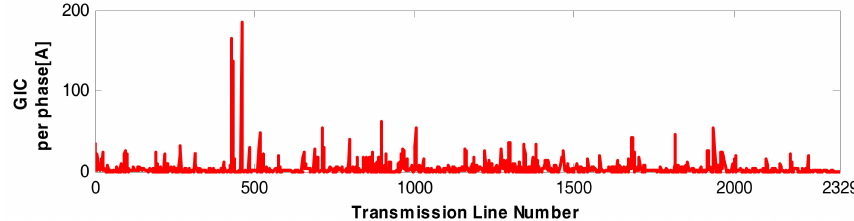
Figure 5. GIC per phase (in absolute value) on the Transmission Line.